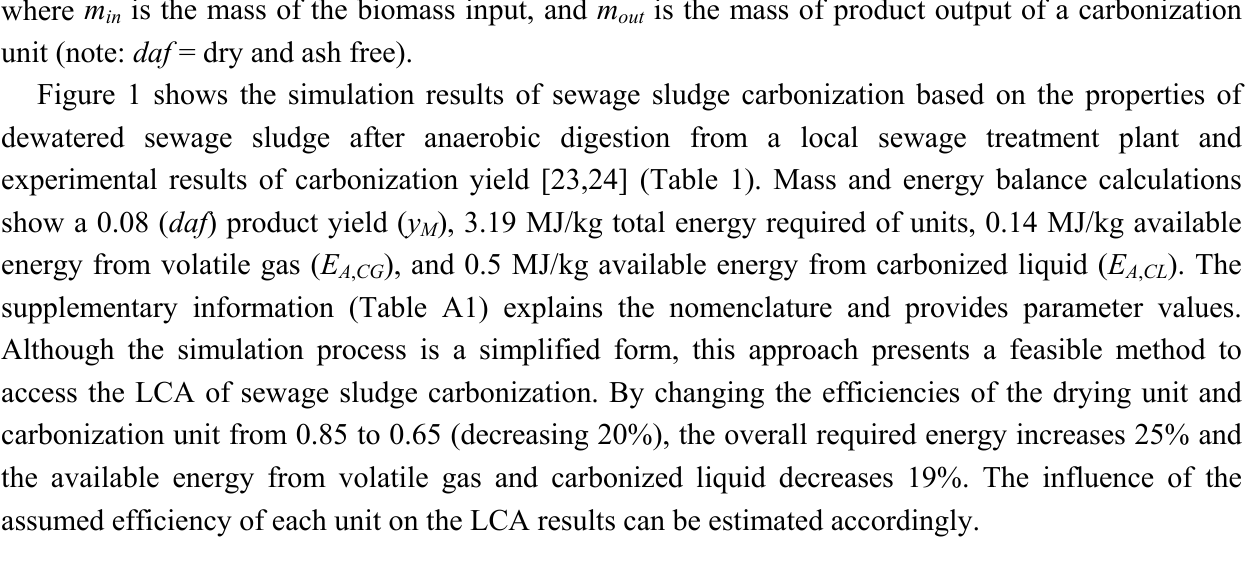
Figure 1. Mass and energy balances of the sewage sludge carbonization